Question: What form of chart is displayed?
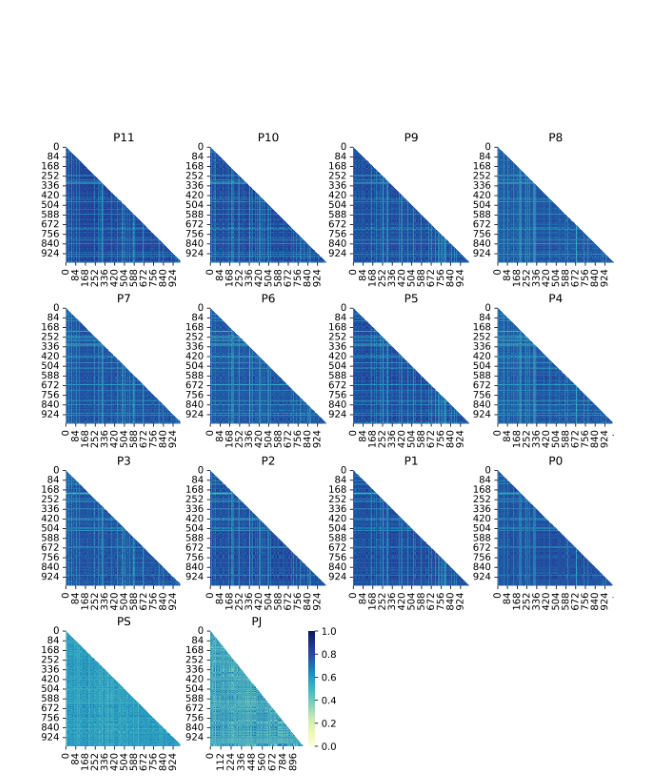
Answer: heatmap